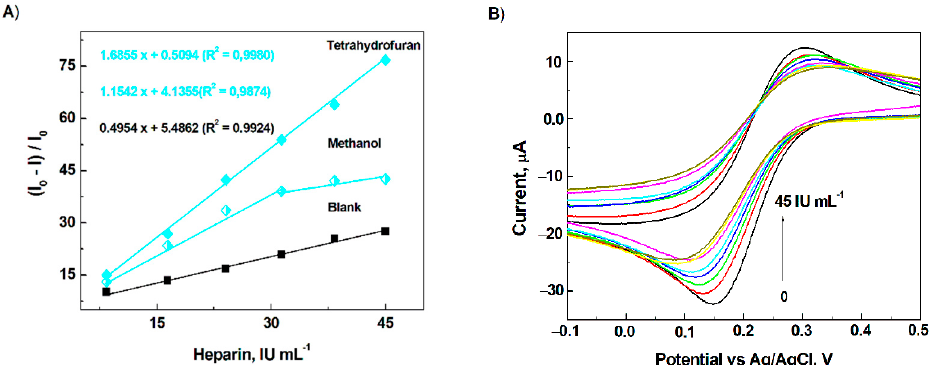
Figure 5. ( A ) Effect of organic solvent used for dispersing of composite AuNPs and PMS1 on the voltammetric response. ( B ) Cyclic voltammograms obtained with the AuNPs/MS1-modified GC electrode after addition of different concentrations of heparin. (Supporting electrolyte: 1 mmol L − 1 Fe(CN) 6 − 3 /Fe(CN) 6 − 4 in 0.1 mol L − 1 PBS (pH = 7). Scan rate 50 mV s − 1 .).